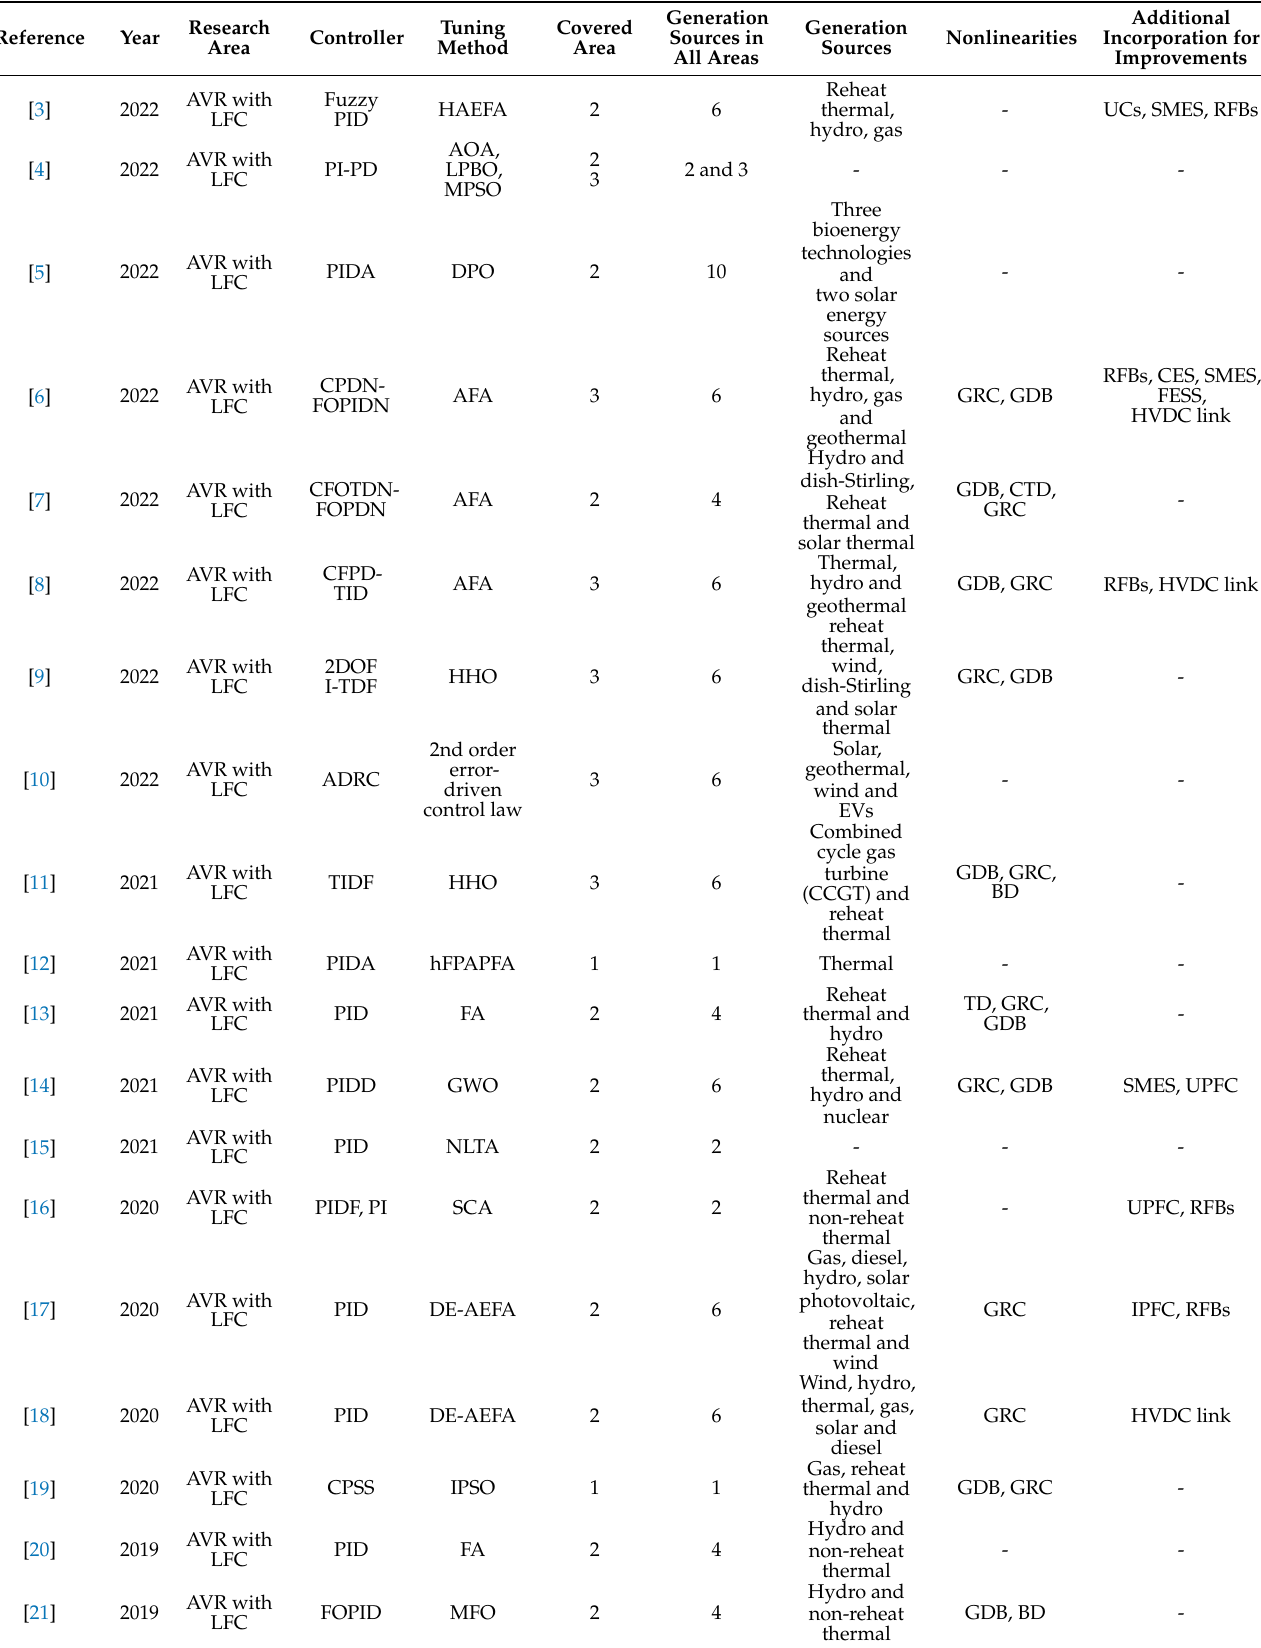
Table 2. Literature summary of combined LFC-AVR